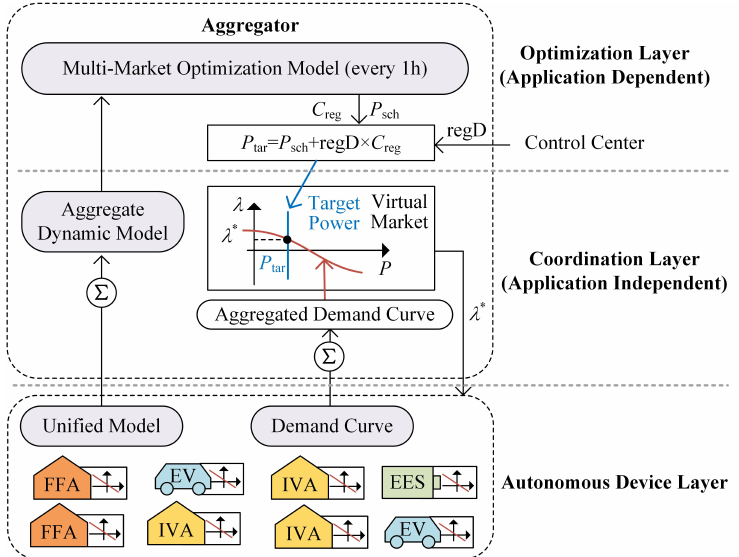
Figure 6. Three-layer control